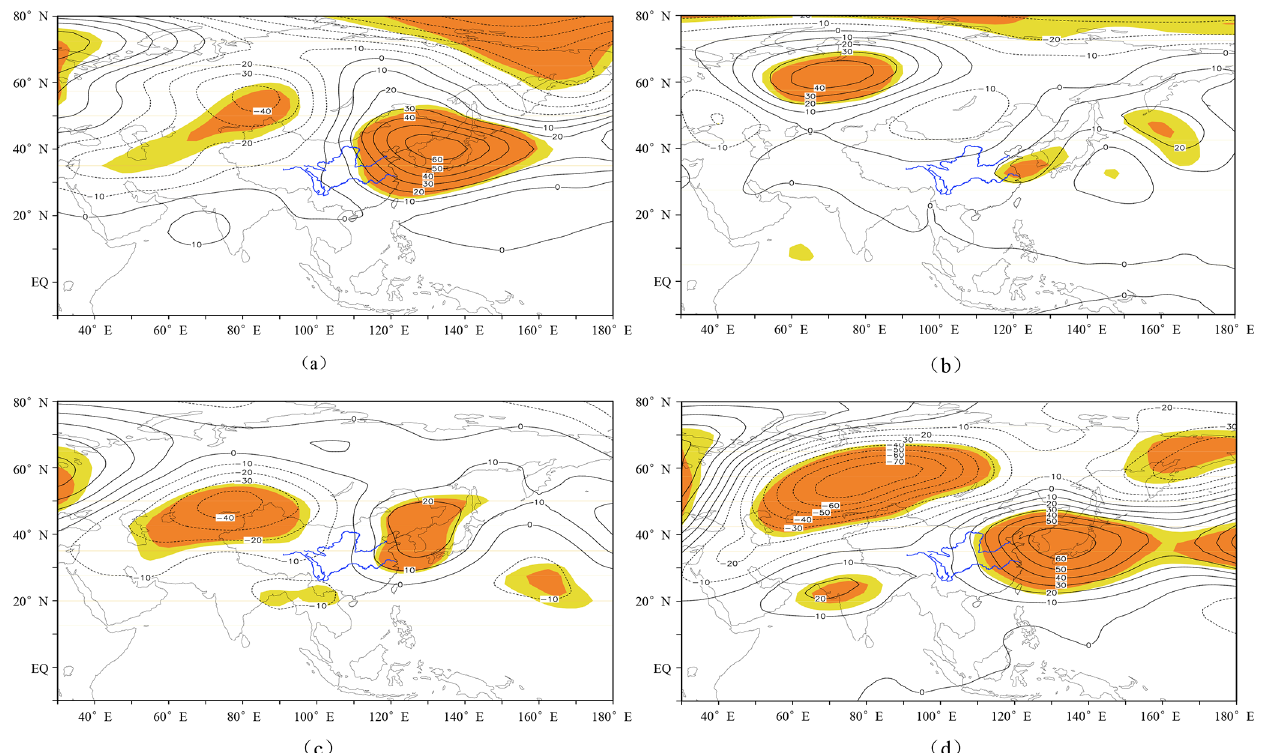
Figure 2. The differences between the height anomaly fields at 500hPa for the years with extremely excessive precipitation and those for the years with extremely deficient precipitation in spring (a) , summer (b) , autumn (c) and winter (d) . (The yellow and orange parts respectively indicated the area passing the significance test at 0.1 and 0.05